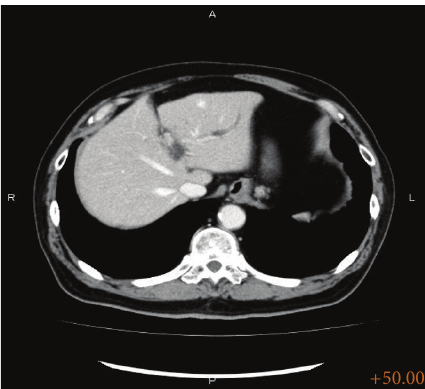
Figure 1: Enhanced CT examination revealed dilatation of the intrahepatic bile duct in the left hemiliver.